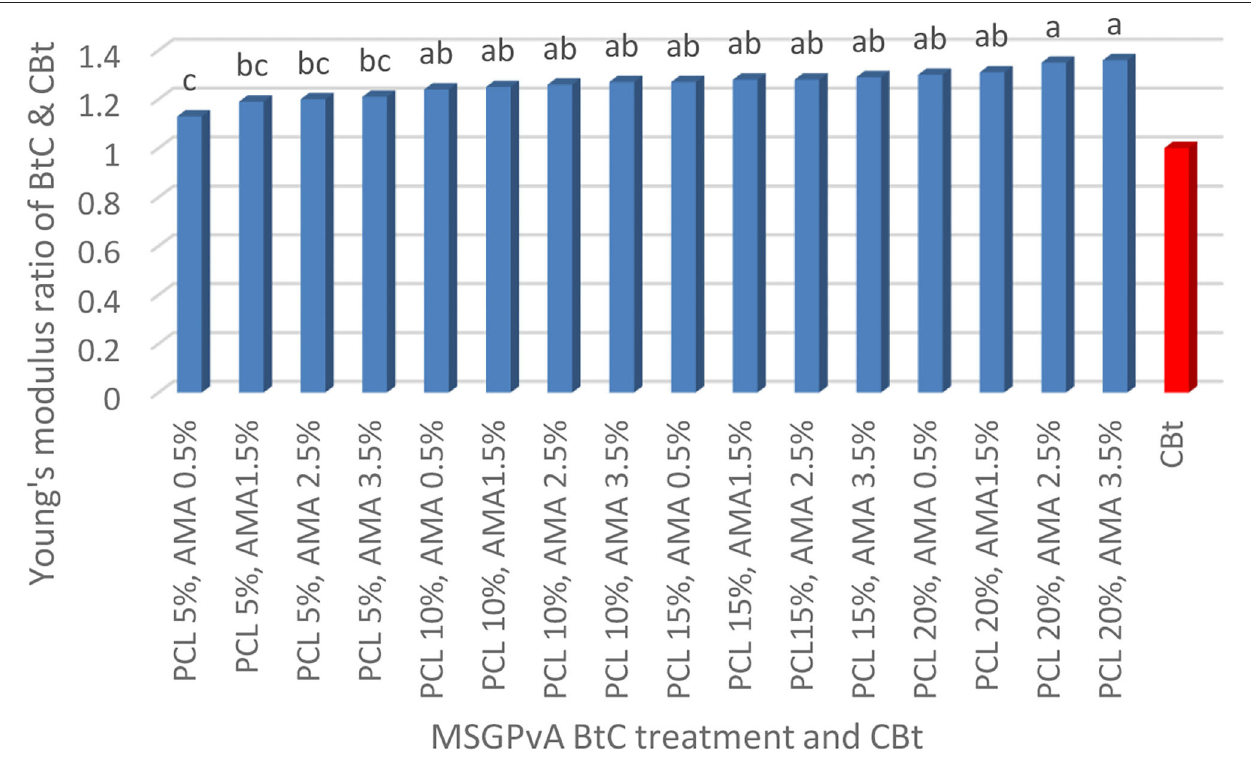
FIGURE 3 | Relationship of MSGPvA BtC and CBT with Young’s modulus ratio of BtC to